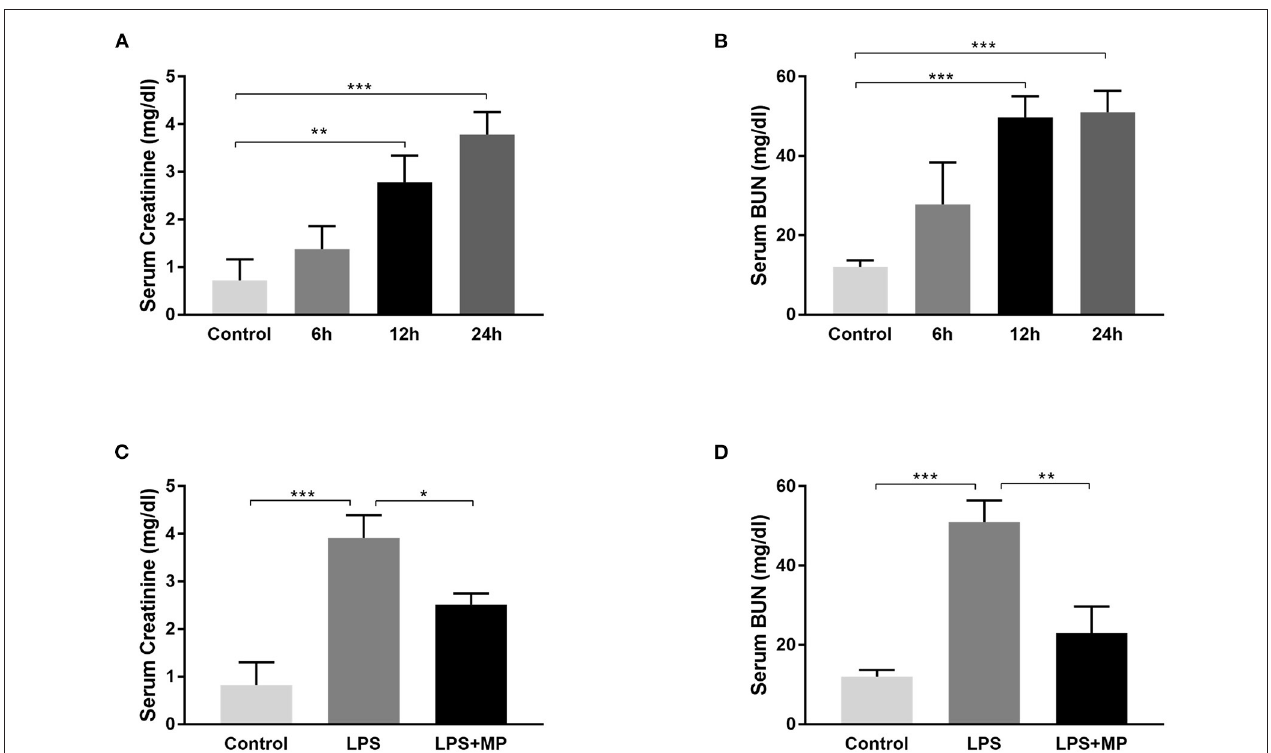
FIGURE 1 | Lipopolysaccharide (LPS) induces acute kidney injury (AKI) in mice and was ameliorated by methylprednisolone (MP) treatment. (A) Serum creatinine levels and (B) serum blood urine nitrogen (BUN) levels of mice treated with LPS for different periods. (C) Serum creatinine levels and (D) serum BUN levels of mice treated with LPS and MP. * P < 0.05, ** P < 0.01, *** P <